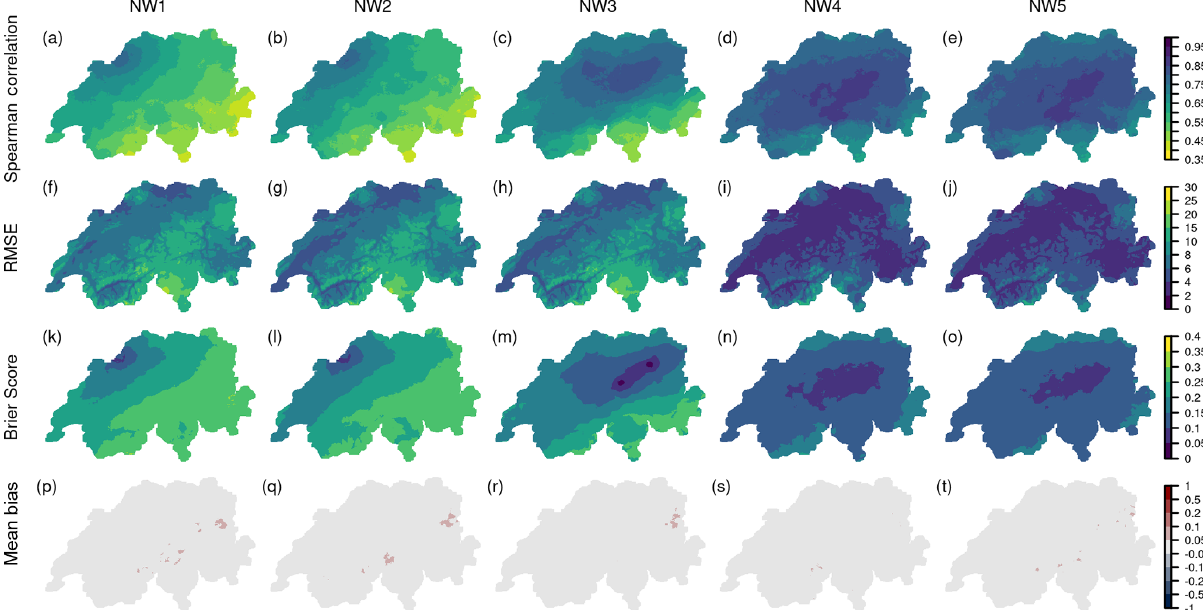
Figure A2. Cross-validation results of all networks shown in Fig. 1a–e with 11, 21, 32, 43, and 108 time series used for reconstructing the precipitation fields. The cross-validation results are based on annual daily precipitation during 1961–2020. (a–e) Spearman correlation, (f–j) RMSE, (k–o) Brier score, and (p–t) mean bias. The RhiresD data set also contains the northern catchments that drain into Switzerland.